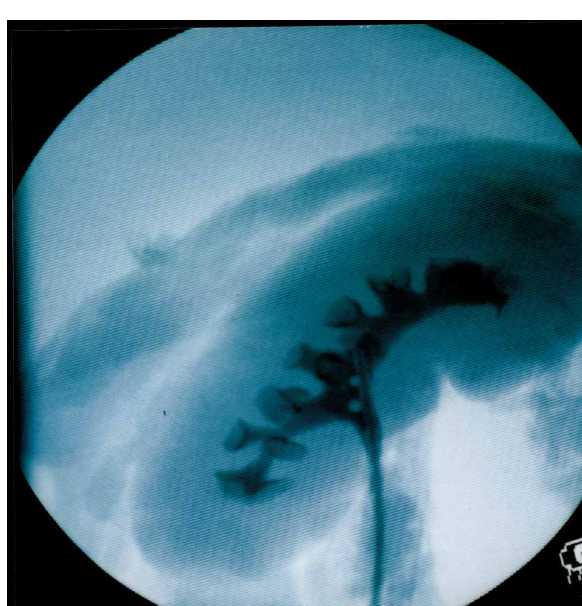
Figure 4 - Retrograde pyelography, showing the renal shadow and the renal collecting system.